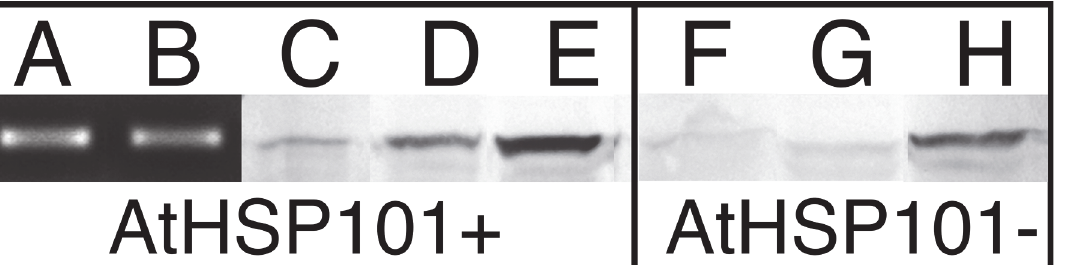
Fig 4. Photographs of RT-PCR and Western Blot analysis showing the expression of AtHSP101 and presence of HSP101 proteins in transgenic cotton lines. RT-PCR products from pollen (A) and leaf (B) tissues of transgenic line 40 plants grown in 31°C/27°C greenhouse; Western blot analysis of HSP101 for: mature pollen of transgenic line 40 (C) and null line 52 (F, AtHSP101 minus) plants grown in a greenhouse set to 31°C/27°C day/night; leaf tissues of transgenic line 40 (D) and null line 52 (G) plants grown in a greenhouse set to 31C°/27°C day/night; leaf tissues of transgenic line 40 (E) and null line 52 (H) plants grown in a hot greenhouse set to 43°C/28°C day/night temperatures.